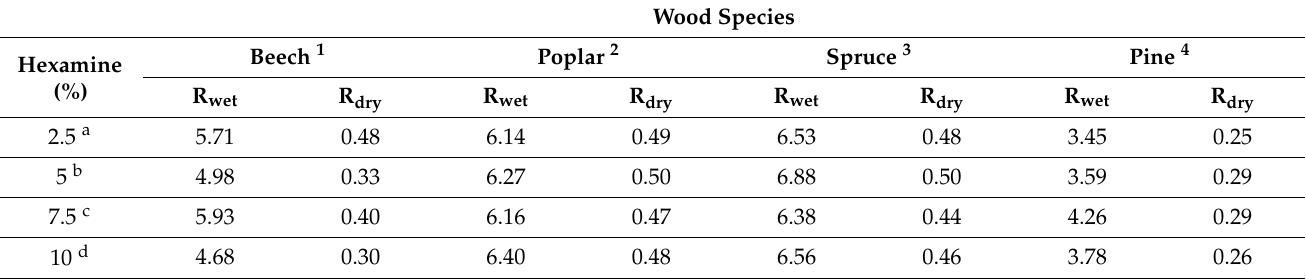
Table 2. Wet and dry retentions for different wood species treated with 10% quebracho tannin solutions with different hexamine